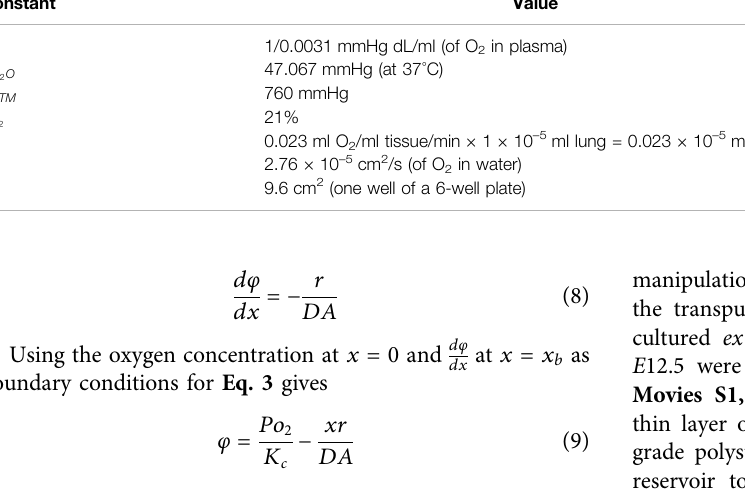
TABLE 2 | Constants used for modeling of oxygen diffusion. Constant